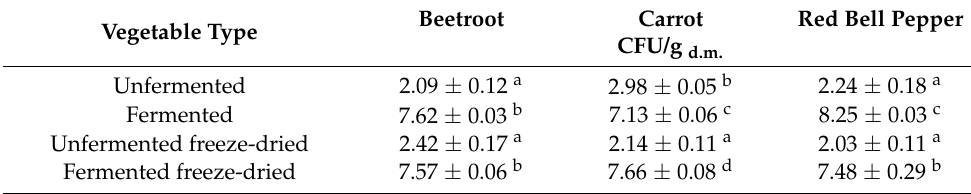
Table 3. Lactic acid bacteria in